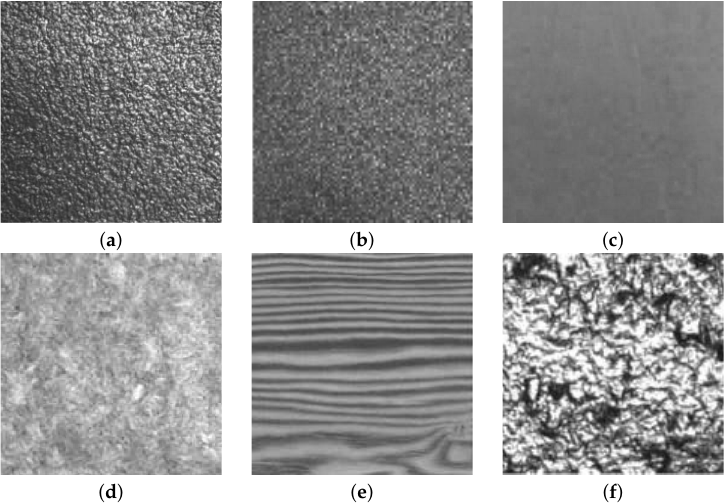
Figure 1. Some statistical textures: ( a ) sandpaper, coarse appearance; ( b ) sandpaper, fine appearance; ( c ) painted surface, fine appearance; ( d ) wool, isotropic; ( e ) wood, high directionality; ( f ) cast metal, irregular.